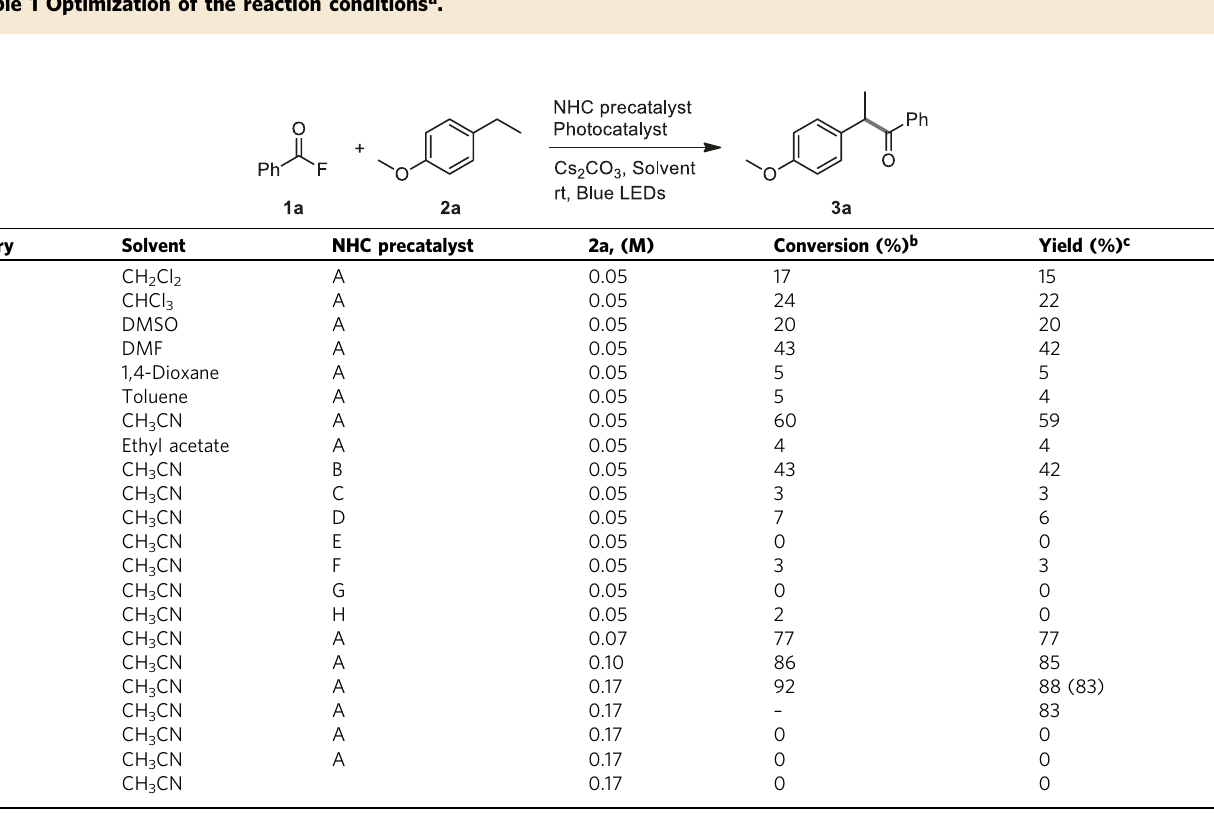
Table 1 Optimization of the reaction conditions a .